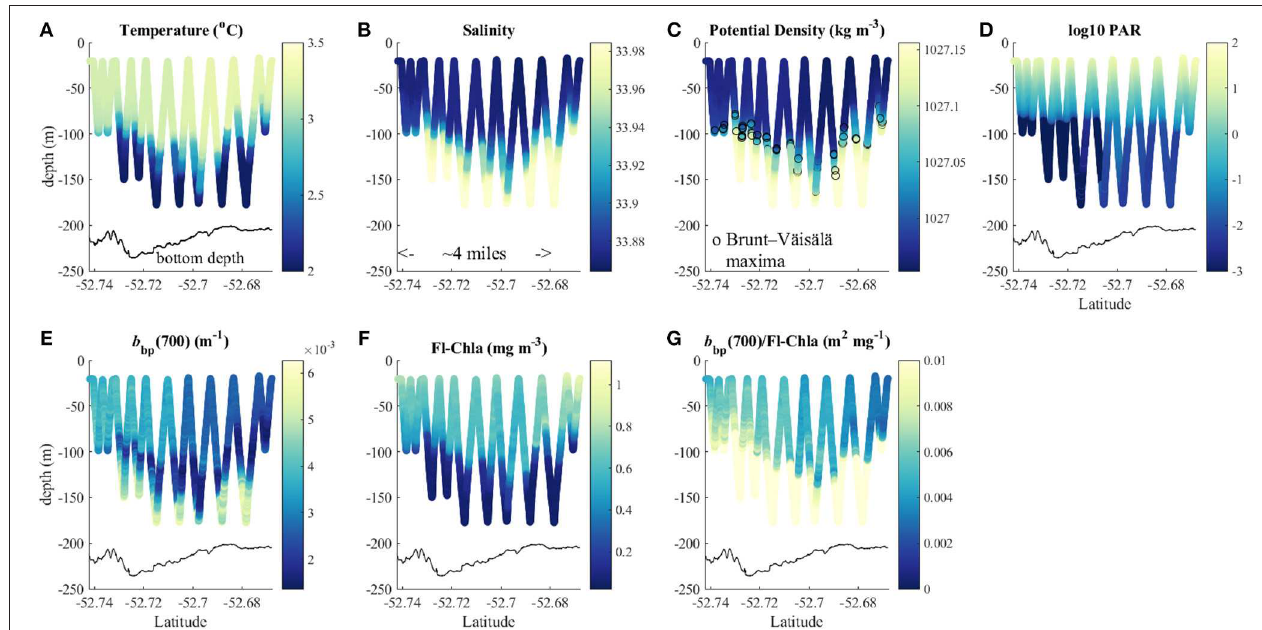
FIGURE 9 | Triaxus transect (A) temperature ( ◦ C), (B) salinity, (C) potential density, (D) log 10 (PAR), particulate backscattering coefficient at 700nm [ b bp (700nm)], (E) fluorescence derived chlorophyll a concentration (Fl-Chla), (F) ratio between particulate backscattering coefficient and chlorophyll a concentration [ b bp (700nm)/Fl-Chla] (G) ; black line in each plot presents the bottom